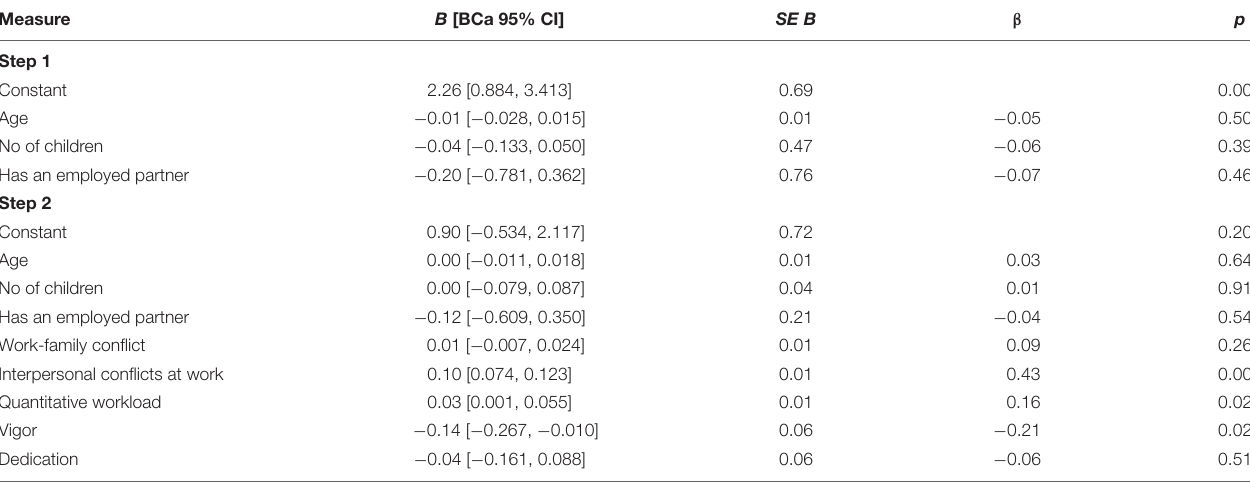
TABLE 4 | Linear model of antecedents of an intention to leave the nursing profession, with 95% BCa CIs in parentheses, among Polish nurses ( N =